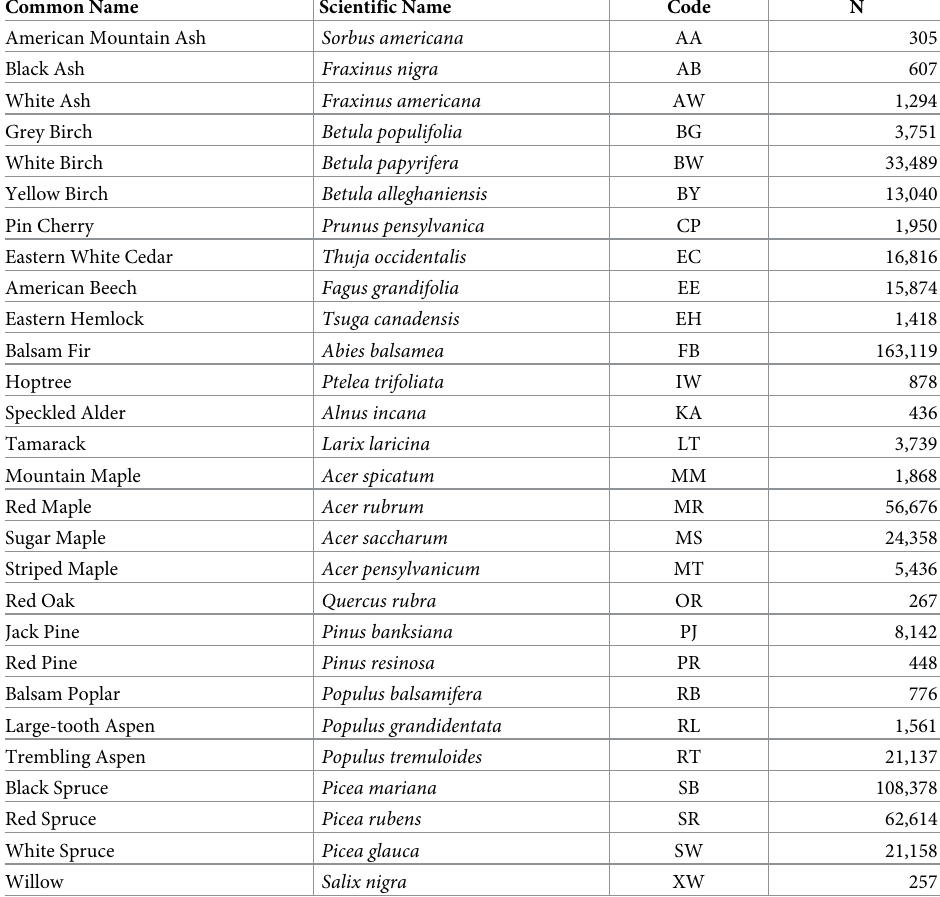
Table 2. Tree species common and scientific names, where N is the number of tree mortality